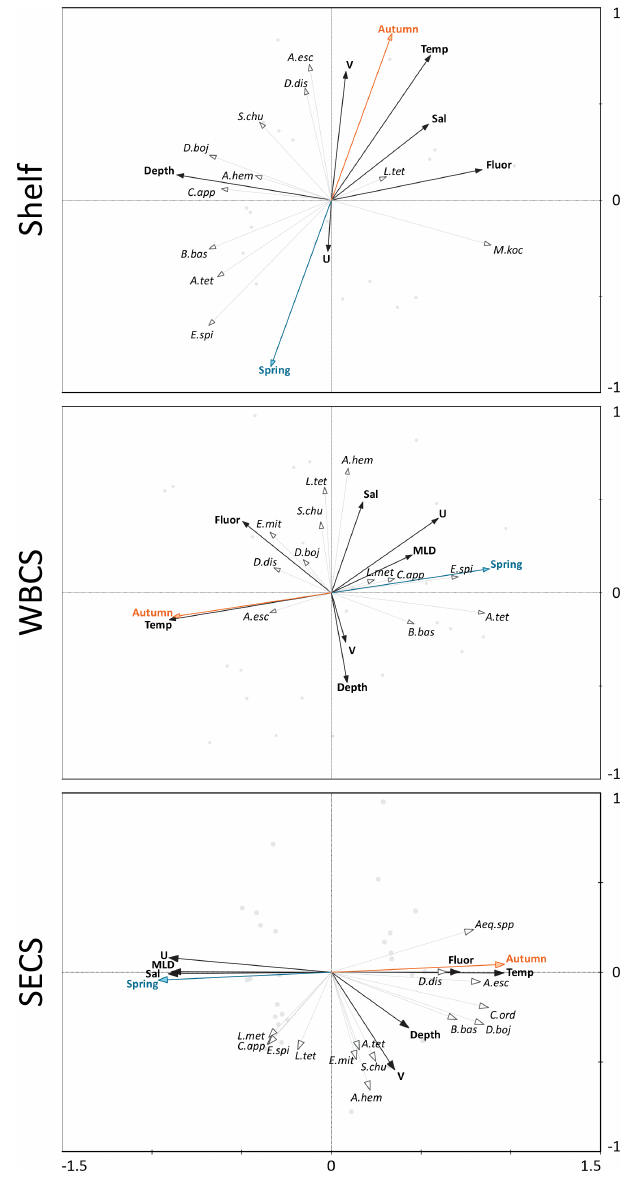
Figure 8. Redundancy analyses (RDAs) performed between the cnidarian community and environmental explanatory variables from the continental shelf, the western boundary current system (WBCS) and the South Equatorial Current System (SECS) in the western tropical South